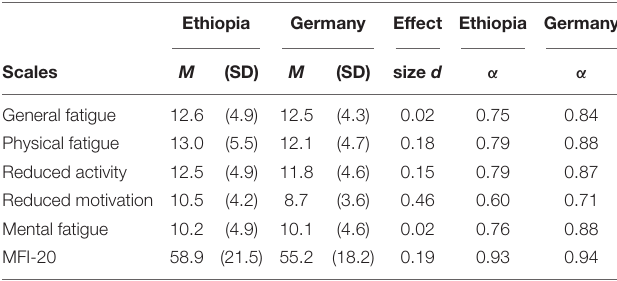
TABLE 2 | MFI-20 means scores and psychometric criteria, comparison between Ethiopia and